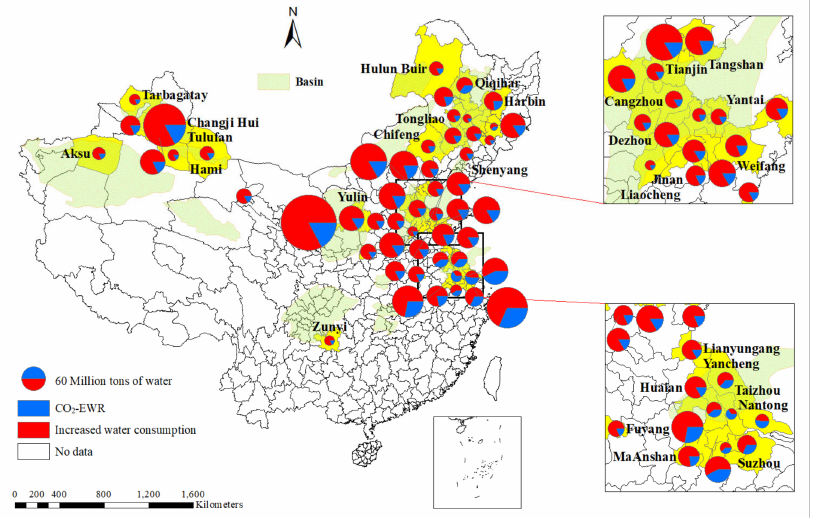
Figure 6. The ratio of water obtained by CO 2 -EWR over the annual increased water consumption caused by the post-combustion